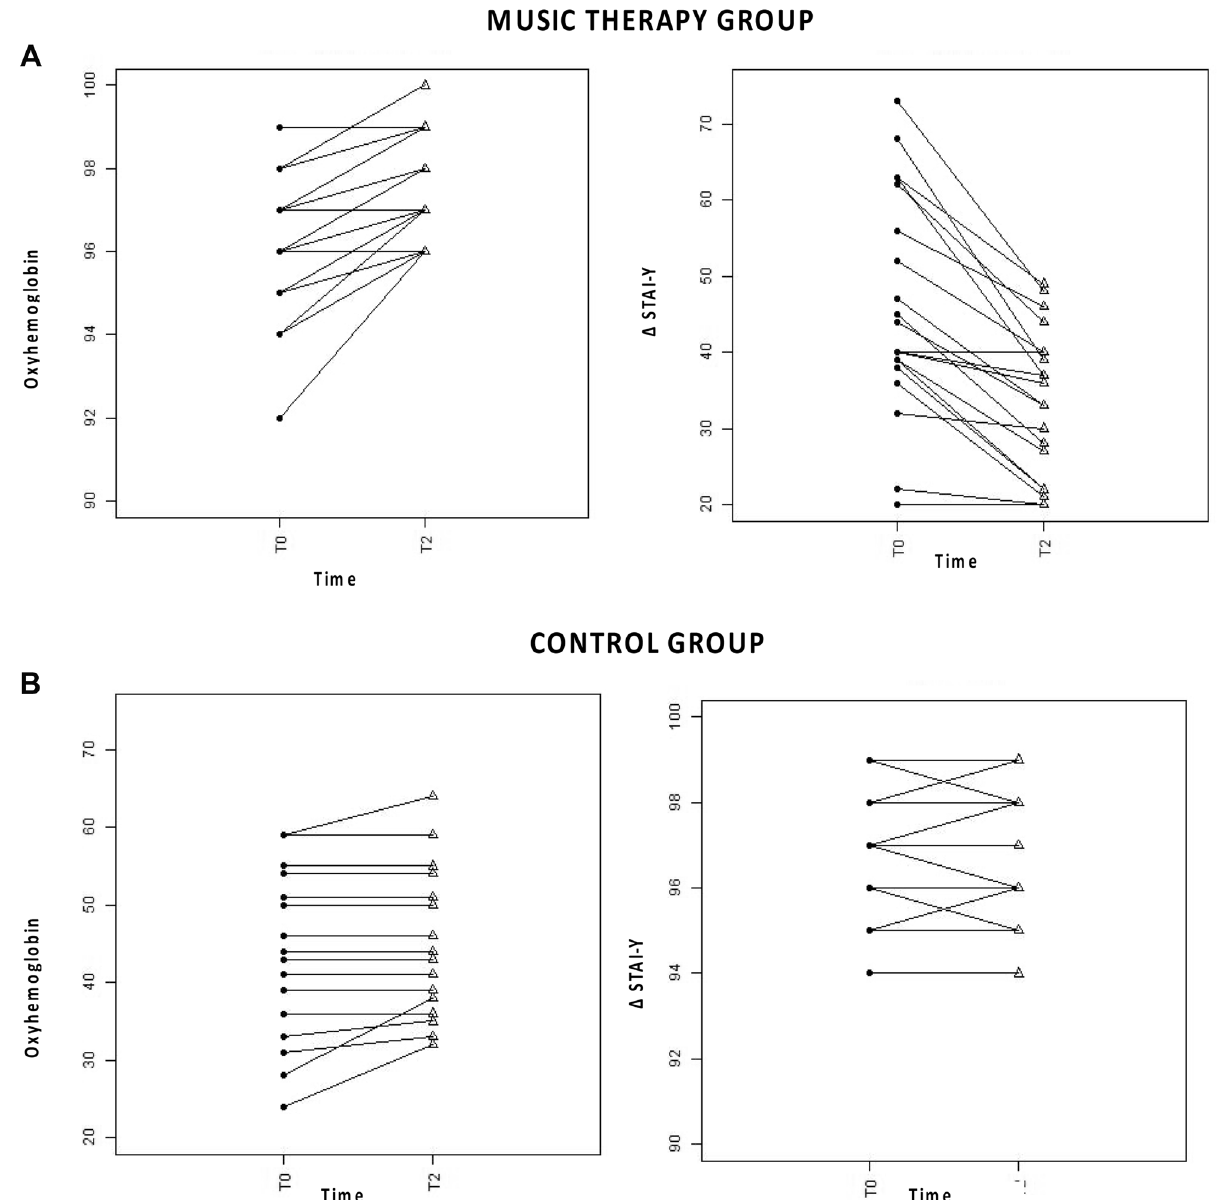
Figure 2. Intra-group comparison between the times T0 and T2. Trend of STAI-Y and oxyhemoglobinic saturation between the beginning and the end of the session in the 20 patients of the MG and in the CG. STAI-Y1 State-Trait Anxiety Inventory—y form, TO time at the start of the session, T1 time during the session, T2 time at the end of the session, STAI-y State-Trait Anxiety Inventory—y form, TO time at the start of the session, T1 time during the session, T2 time at the end of the session. (a) MUSIC THERAPY GROUP. Intra-group comparison between T0 and T2 times regarding the variation of oxyhemoglobin saturation and STAY-Y. (b) CONTROL GROUP. Intra-group comparison between T0 and T2 times regarding the variation of oxyhemoglobin saturation and STAY-Y. *p <